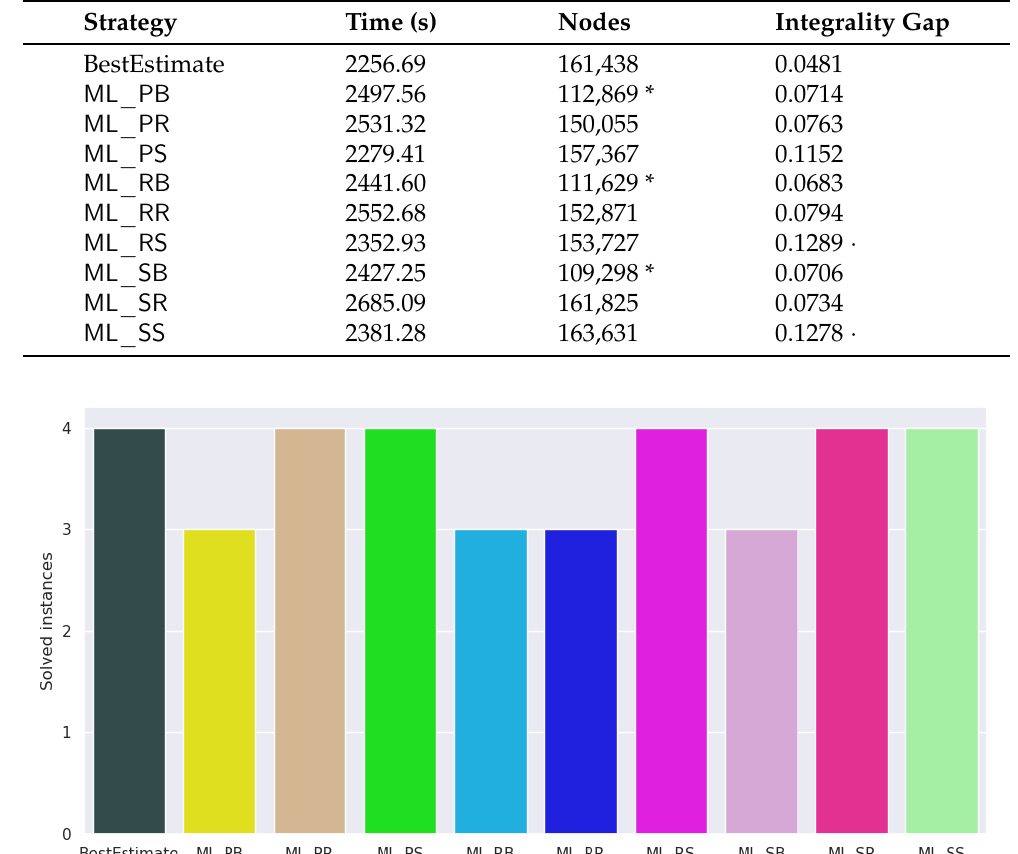
Table 9. Hard set cover instances. Pair-wise t -tests against BestEstimate : ‘*’ p < 0.05, ‘ · ’ p < 0.1.